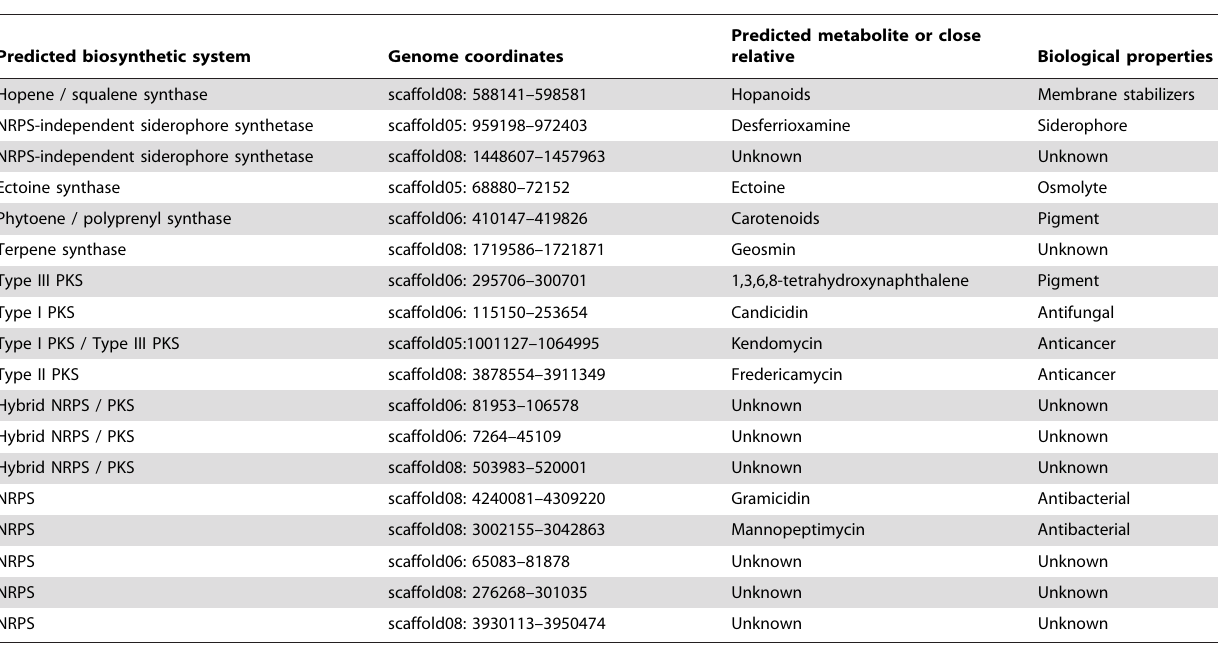
Table 1. Putative secondary metabolites encoded by Streptomyces